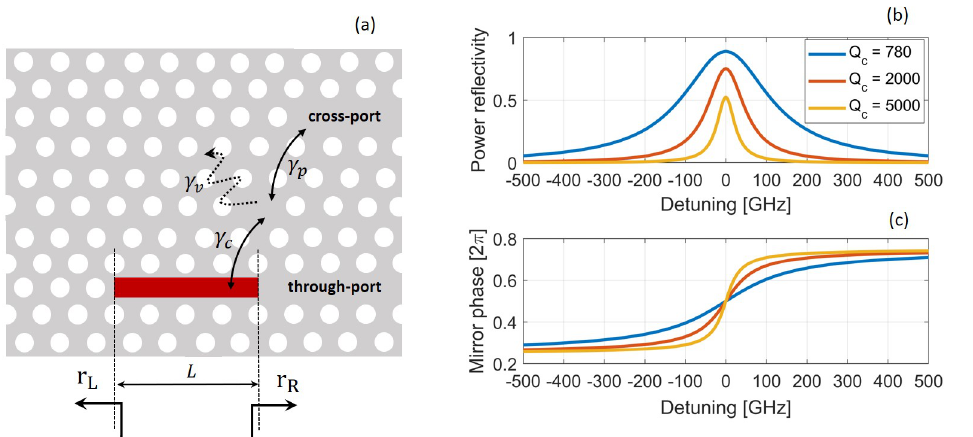
Figure 13. ( a ) Fano laser implementation on the PhC platform. The active region is denoted in red. ( b ) Power reflectivity and ( c ) phase for a Fano mirror with Q v = 10 5 , Q p = 1.5 × 10 4 and different values of Q c versus detuning from the resonance